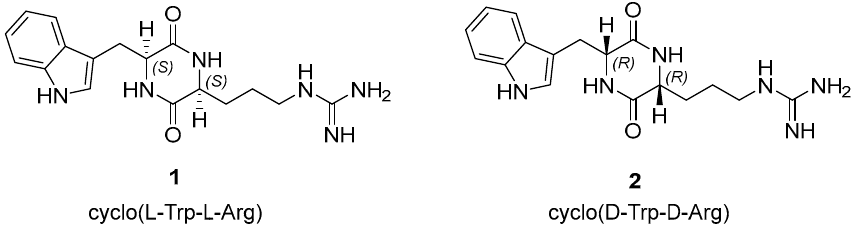
Figure 1. Proposed structures of CDP 2 ( 1 ) and CDP 3 ( 2 ) [8].